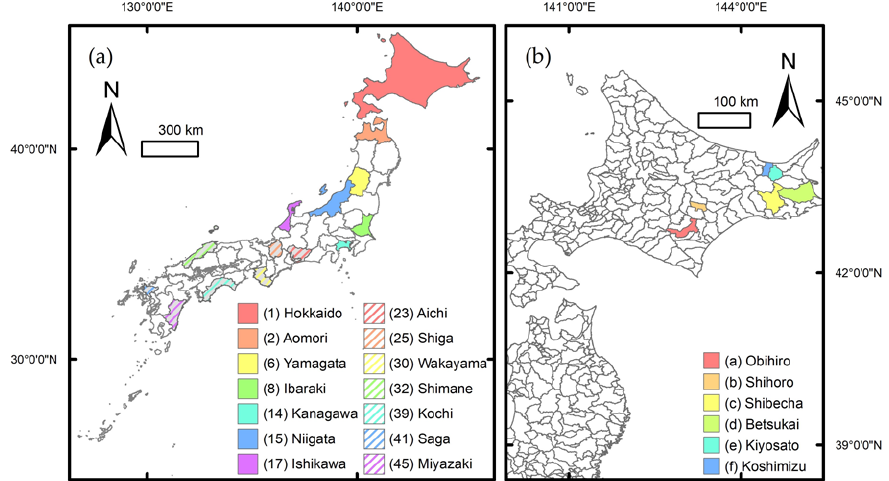
Figure 2. ( a ) The 14 prefectures selected as “Paddy” reference field regions; 100 paddy fields from each of the 14 prefectures were selected as “Paddy” reference fields. ( b ) Six municipal districts in Hokkaido prefecture were selected as regions for “Not paddy” reference fields. All agricultural fields in these six districts were selected as “Not paddy” reference fields.